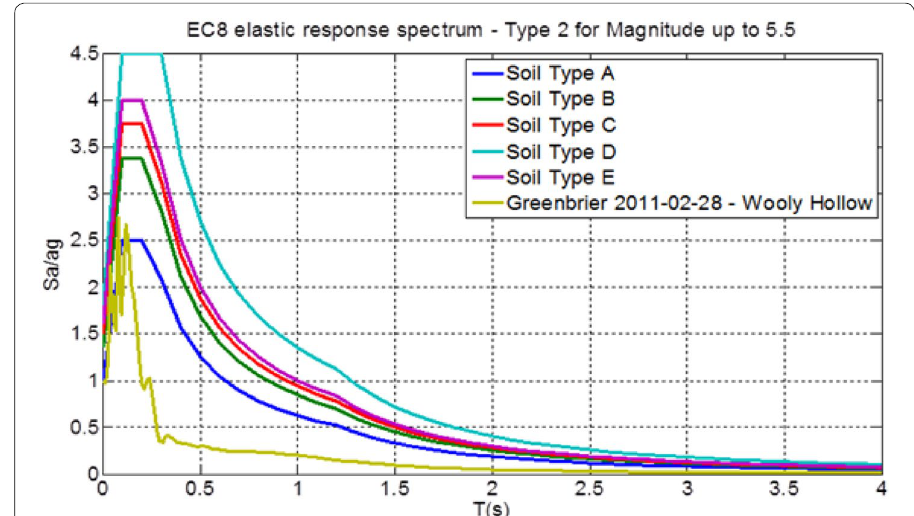
Fig. 9 Elastic response spectra of the induced seismic ground motions obtained from the PEER database and their comparison with the Eurocode 8 type 2 elastic response spectrum for magnitudes up to 5.5. In the legend, the soil types A–E (rock [A] to softer soils [E]) refer to the different Eurocode 8 type 2 elastic response spectra produced for different soil conditions according to Eurocode 8. The remaining term in the legend refers to the name of the seismic station (PEER Database) which recorded the induced seismic event’s (Greenbrier, Table 1) ground motion used to produce the elastic response spectrum